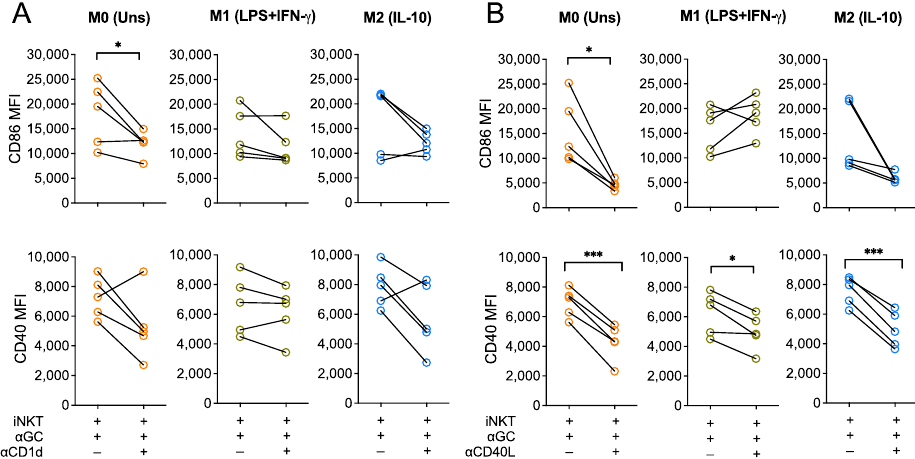
Figure 2. CD40L engagement is required for iNKT-mediated activation of macrophages. CD86 and CD40 expression (MFI) of M0 (Unstimulated), M1- (LPS+IFN- γ -stimulated) and M2-like (IL-10-stimulated) macrophages were co-cultured with iNKT cells and α -GalCer (60 nM) for 18 h in the presence or absence of ( A ) anti-CD1d or ( B ) anti-CD40L blocking antibodies, added to the medium 1 h prior co-cultures. Data are representative of 5 independent experiments. * p < 0.05; *** p < 0.001. Paired t -test.